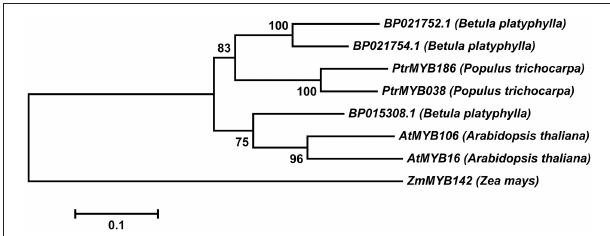
FIGURE 1 | Phylogenetic tree of R2R3- MYB genes from different model plant species constructed with MEGA5 using the neighbor-joining